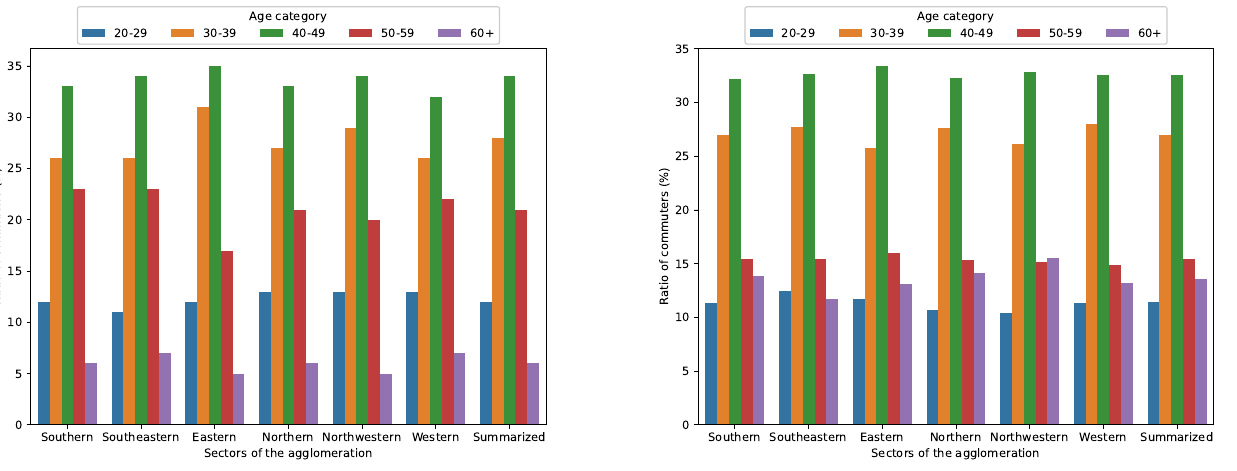
Figure 6. Comparision of commuting to Budapest from the sectors of the agglomeration by age